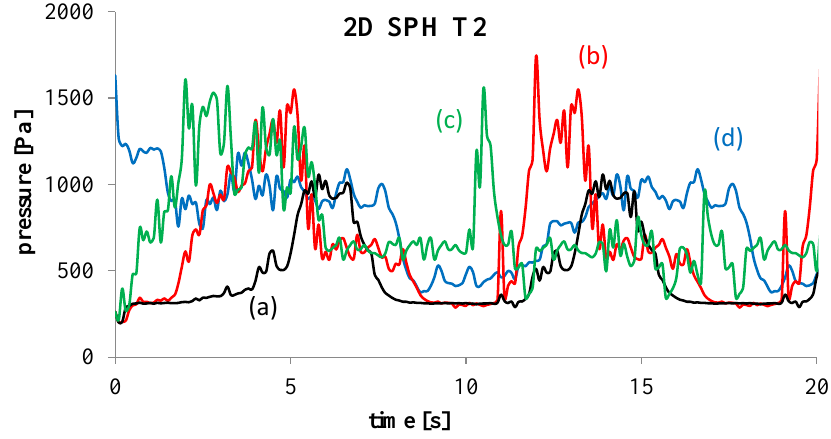
Figure 18. Time series of the pressure under hydraulic jump (configuration: T2) at a distance of: ( a ) 7 cm; ( b ) 10 cm; ( c ) 20 cm; and ( d ) 100 cm, from the time-averaged position of the hydraulic jump toe.